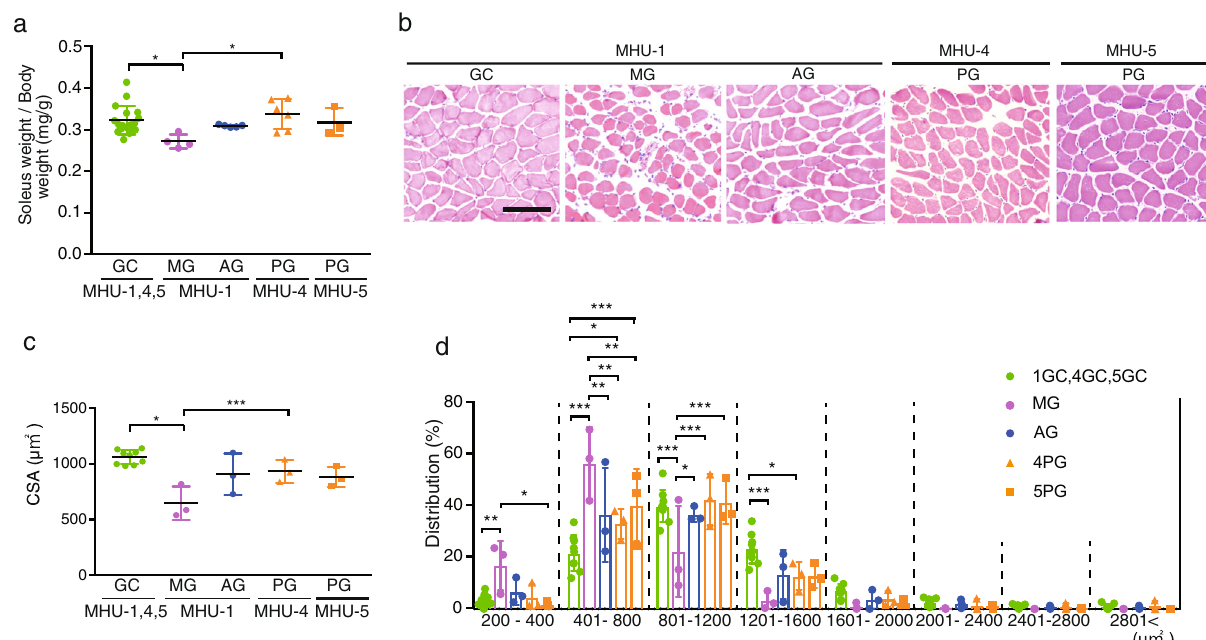
Fig. 2 Effect of lunar gravity on the soleus muscle. a Soleus muscle weights normalized to total body weight (mg/g) from mouse habitat unit (MHU)-1, -4, and -5 missions and ground control (GC). Data are represented as the mean and standard deviation (SD), and each point represents an individual mouse; MHU-1_MG: n = 4; MHU-1_AG: n = 5; MHU-4_PG: n = 6; MHU-5_PG: n = 3; GC: n = 18. b Hematoxylin – eosin staining of the soleus muscle cross sections. Scale bar, 100 μ m. c Cross-sectional area (CSA) of the soleus myo fi bers in each group ( n = 3). n = 9 for GC. Data are represented as the mean and SD, and each point represents an individual mouse. d CSA distribution of the soleus muscles in each group ( n = 3). n = 9 for GC. Data are represented as the mean and SD, and each point represents an individual mouse. * P < 0.05, ** P < 0.01, and *** P < 0.001, as determined using Tukey ’ s test. 1GC: